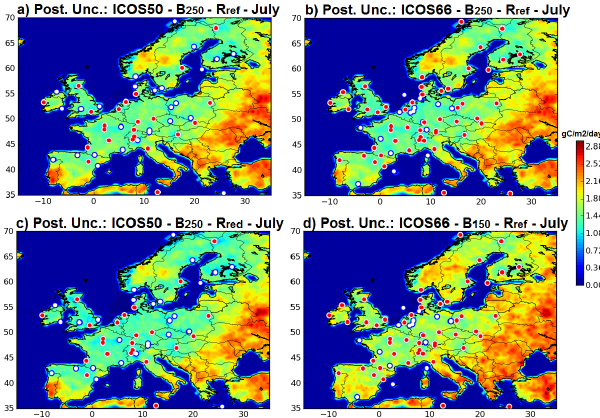
Figure A3. Standard deviations (gCm − 2 day − 1 ) of the posterior uncertainties in a 2-week-mean NEE at 0.5 ◦ resolution for July when using ICOS50 (a, c) and ICOS66 (b, d) , the reference inver- sion configuration (a, b) , using B 150 instead of B 250 and (d) R red instead of R ref (c) . Red dots corresponds to the ICOS23 (a, c) or ICOS50 (b, d) sites while white dots correspond to the addi- tional sites included in ICOS50 or ICOS66. Red/blue colors indi- cate relatively high/low uncertainties (with min = 0gCm − 2 day − 1 and max = 3gCm − 2 day − 1 in the color